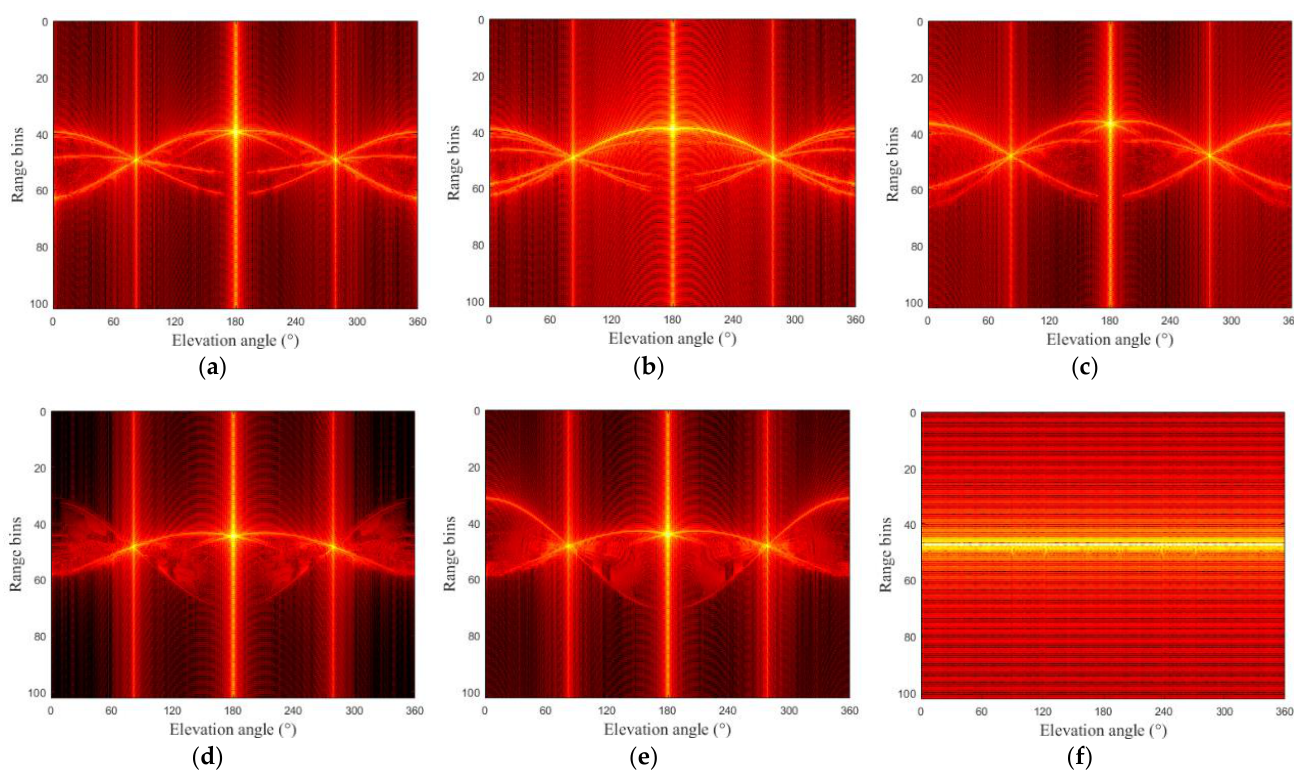
Figure 5. Variation of the HRRPs of the six targets with the elevation angle. ( a ) Warhead 1; ( b ) warhead 2; ( c ) warhead 3; ( d ) decoy 1; ( e ) decoy 2; ( f ) decoy 3.